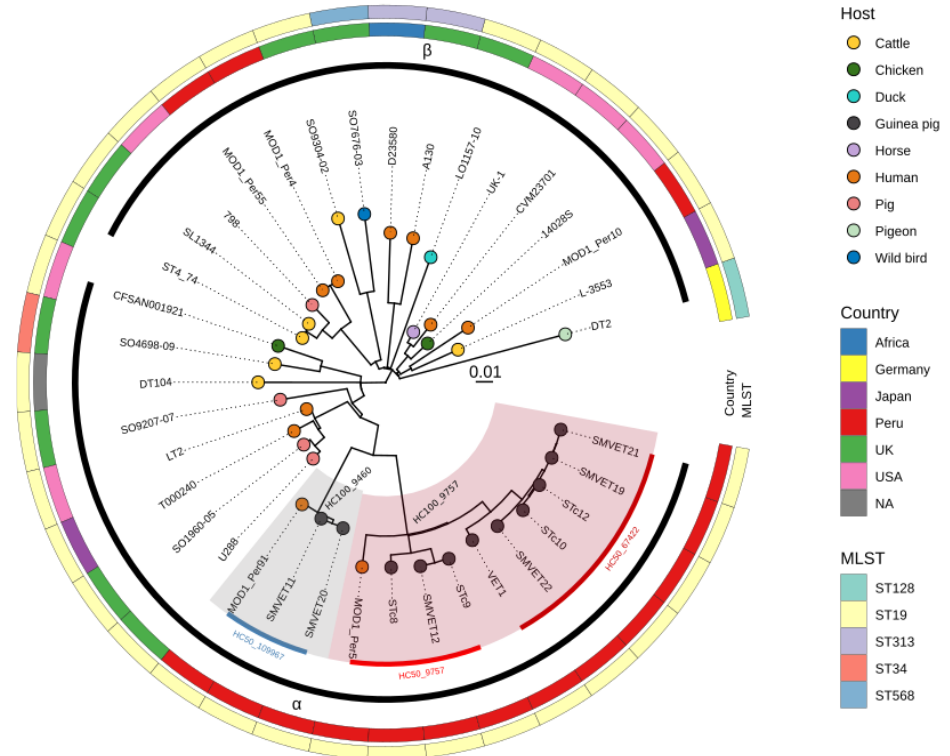
Figure 1. Phylogenetic tree of S. Typhimurium genome sequences isolated from guinea pigs in a context of 26 S. Typhimurium isolates from different hosts and locations including five sequences from Peruvian human sources. Two genetic clusters containing guinea pig isolates are highlighted in gray [HC100_9460] and red [HC100_9757]. The latter contains, in turn, two subclusters of H50: HC50-67422 and HC50-9757, that are represented by dark red and red bars, respectively.